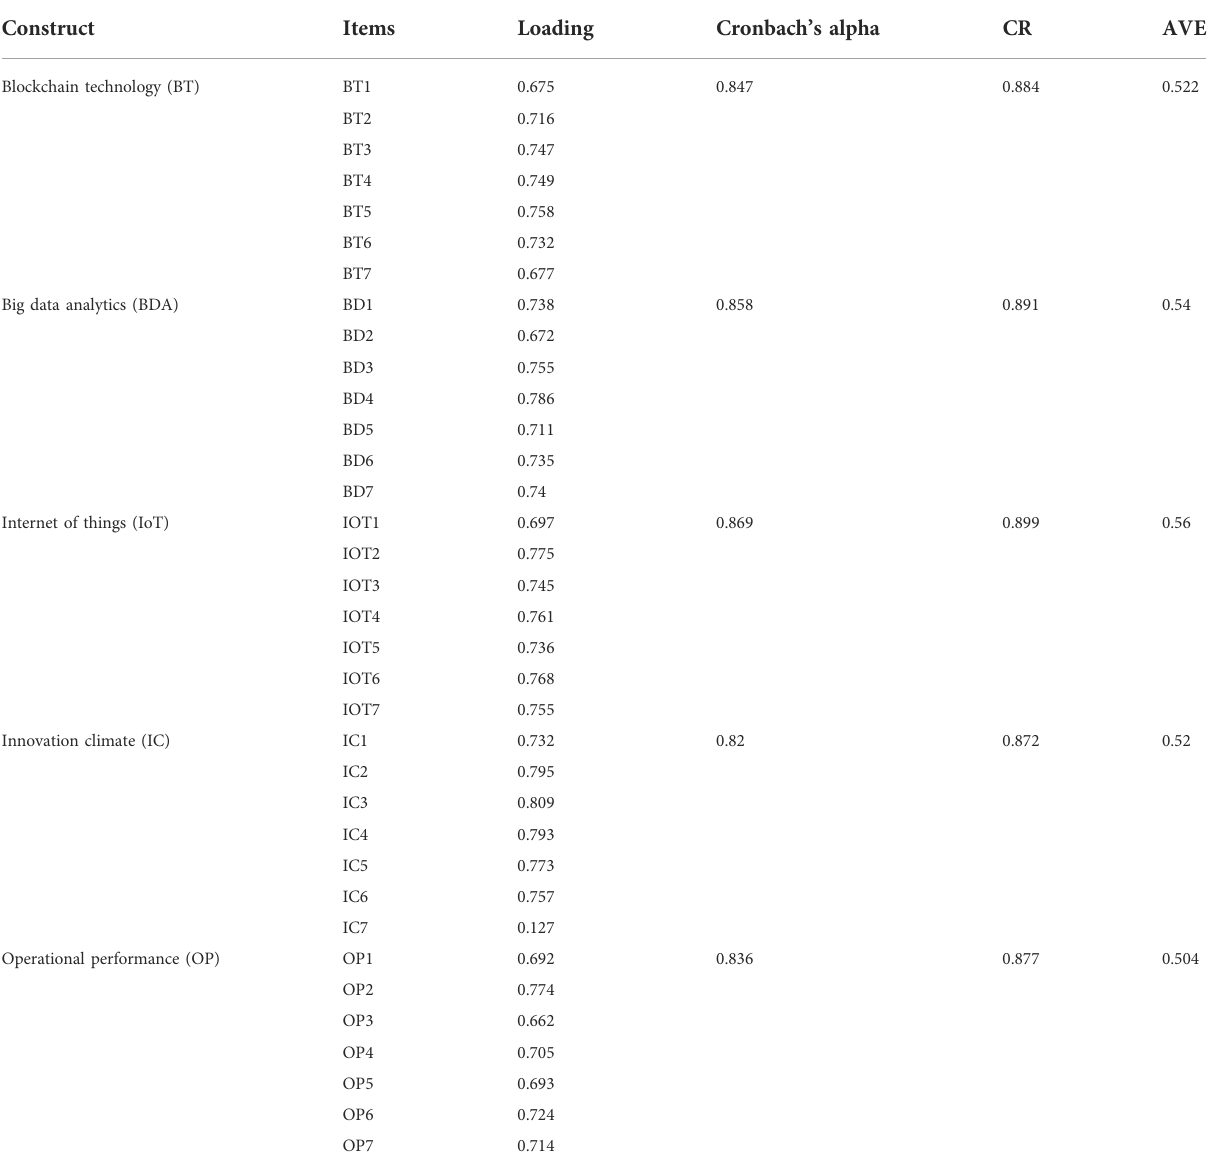
TABLE 4 Reliability, and convergent validity